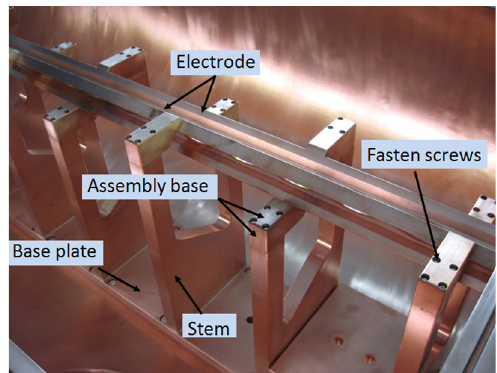
FIG. 15. An inner view of the RFQ structure. FIG. 16. RFQ mechanical